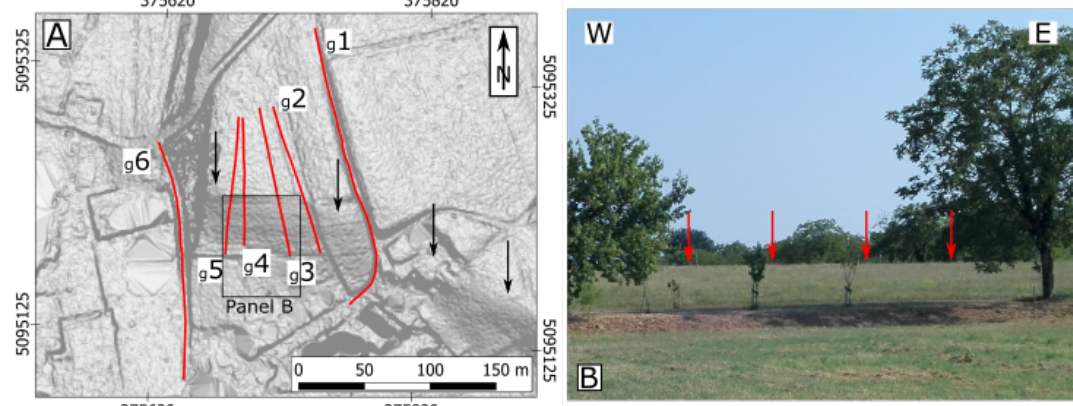
Figure 10. ( A ): Geophysical profiles (red lines) with the slope map displayed as background image (see Figure 7 for location of the area). The black arrows indicate the scarp. The black rectangle marks the area shown in panel ( B ). ( B ): Field photos of the scarp (from south). The red arrows indicate the uplifted T4 terrace